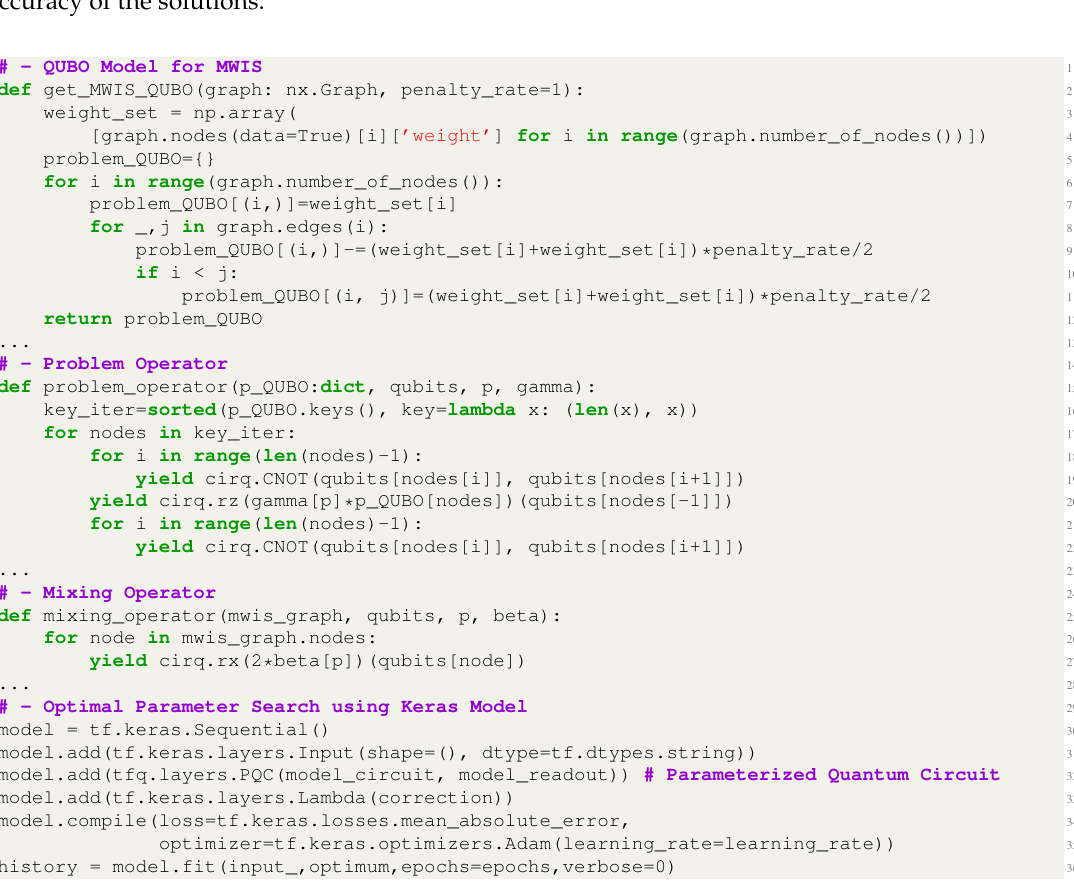
Figure 2. Parts of Python codes using Cirq and TensorFlow-Quantum for solving the maximum weight independent set (MWIS)-based scheduling problem.